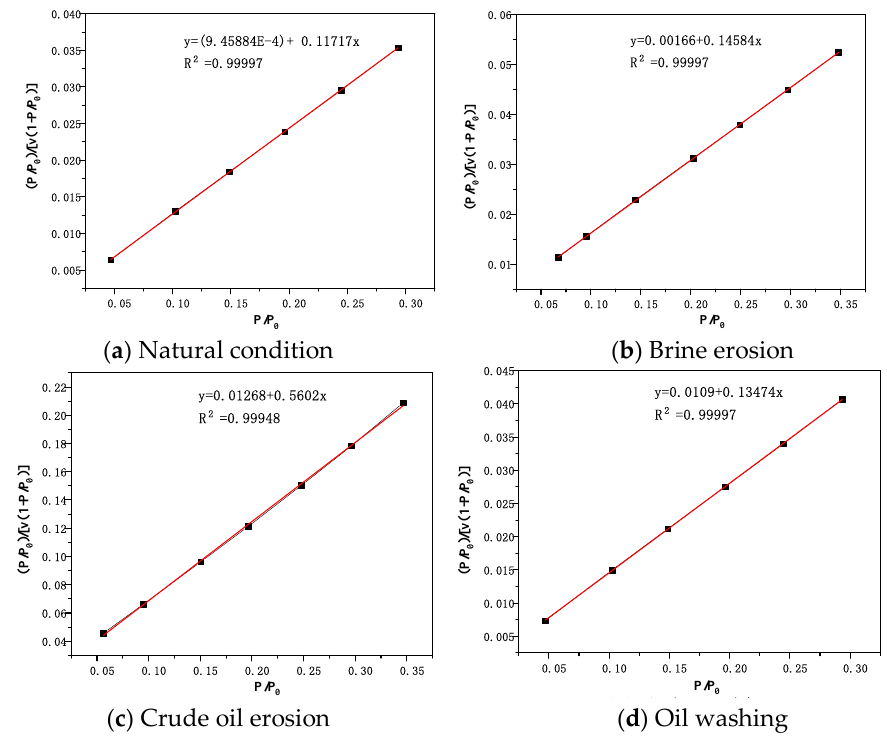
Figure 10. The BET diagrams of interlayer samples after different sample treatment conditions.